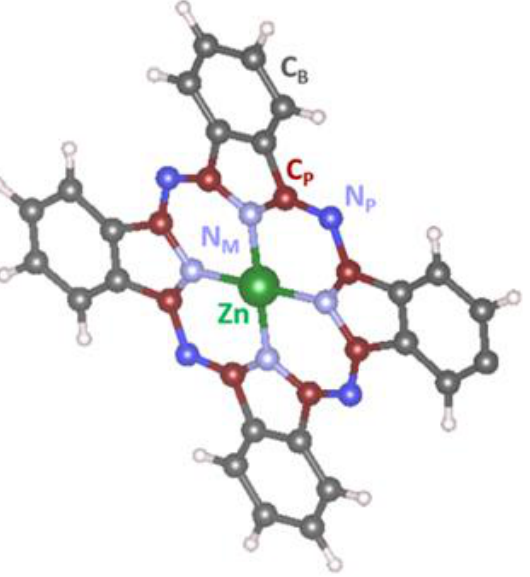
Figure 9. The schematic representation of ZnPc molecule with assignation of benzene-type and pyrrole-type carbons and also different types of nitrogen atoms N P , N M .